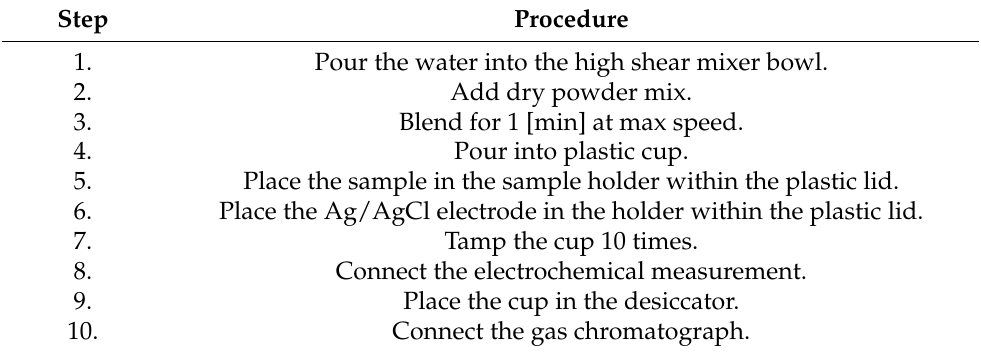
Table 3. The procedure for mixing the cement paste, placing the sample, and connecting the GC and